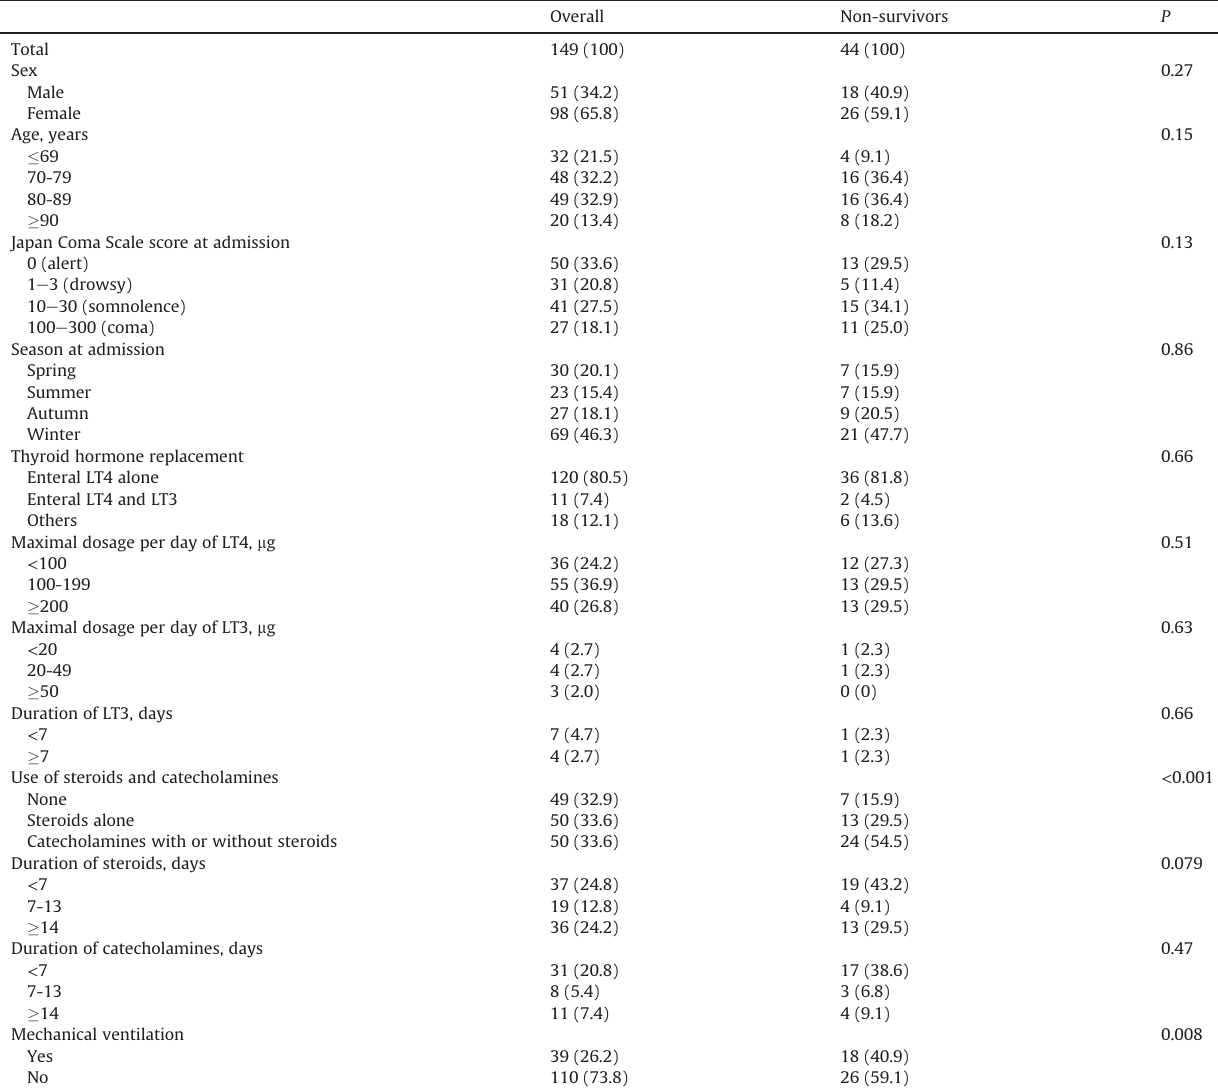
Table 1 Patient